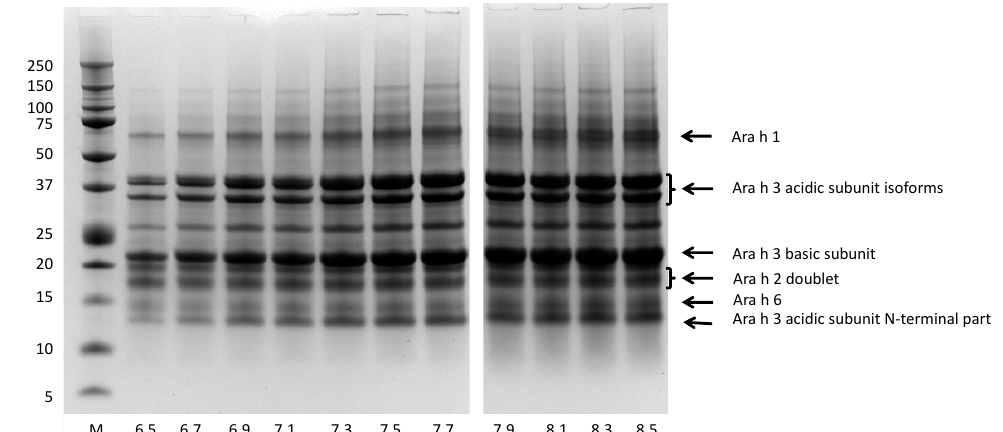
Figure 4. Protein profiles of light roasted peanut flour released at various pHs mimicking saliva. Extraction time 20 min. Protein profiles determined by SDS-PAGE, under reducing conditions, on 10% gels. The molecular weight marker is indicated on the left in kDa. Numbers at the bottom indicate the pH of the extraction buffer. Arrows on the right margin point to major allergens.